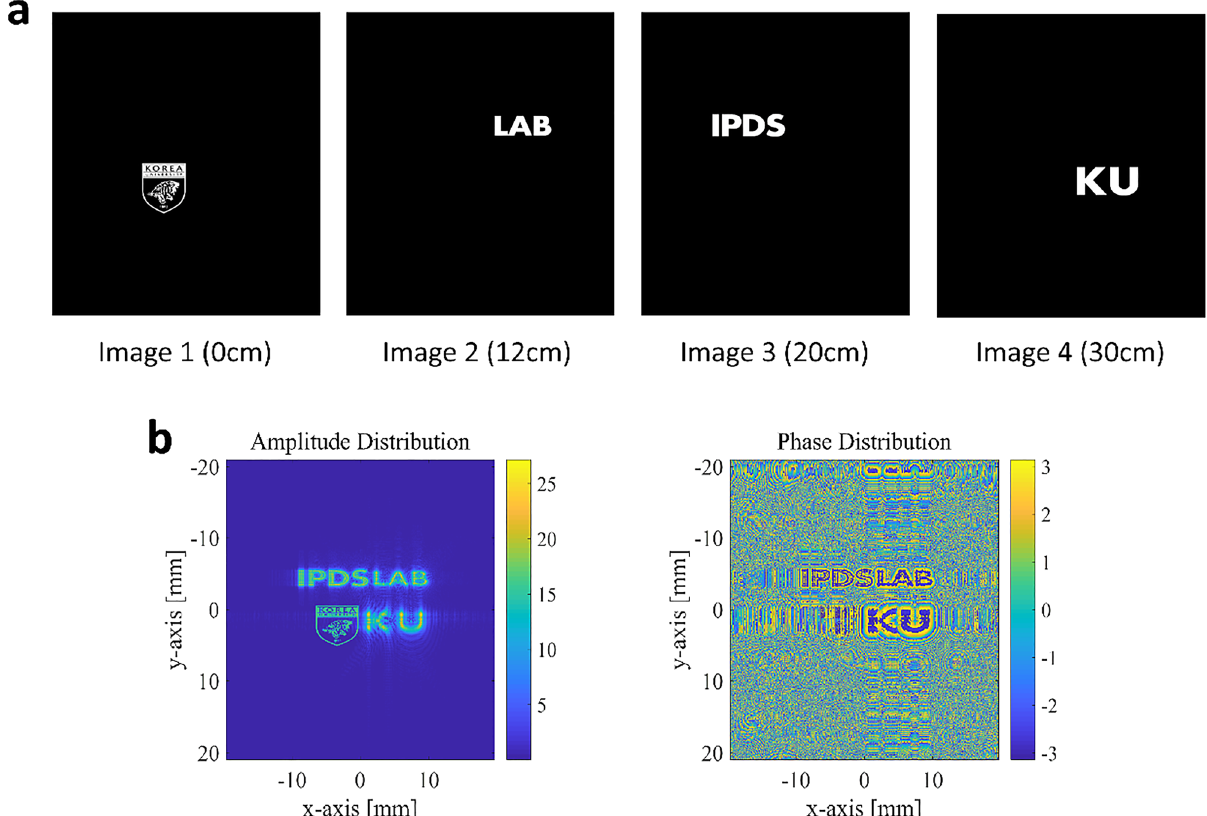
Figure 8. ( a ) Target depth images and the respective focal length of the 4-level CGH. ( b ) The amplitude (left panel) and the phase (right panel) distributions of the calculated